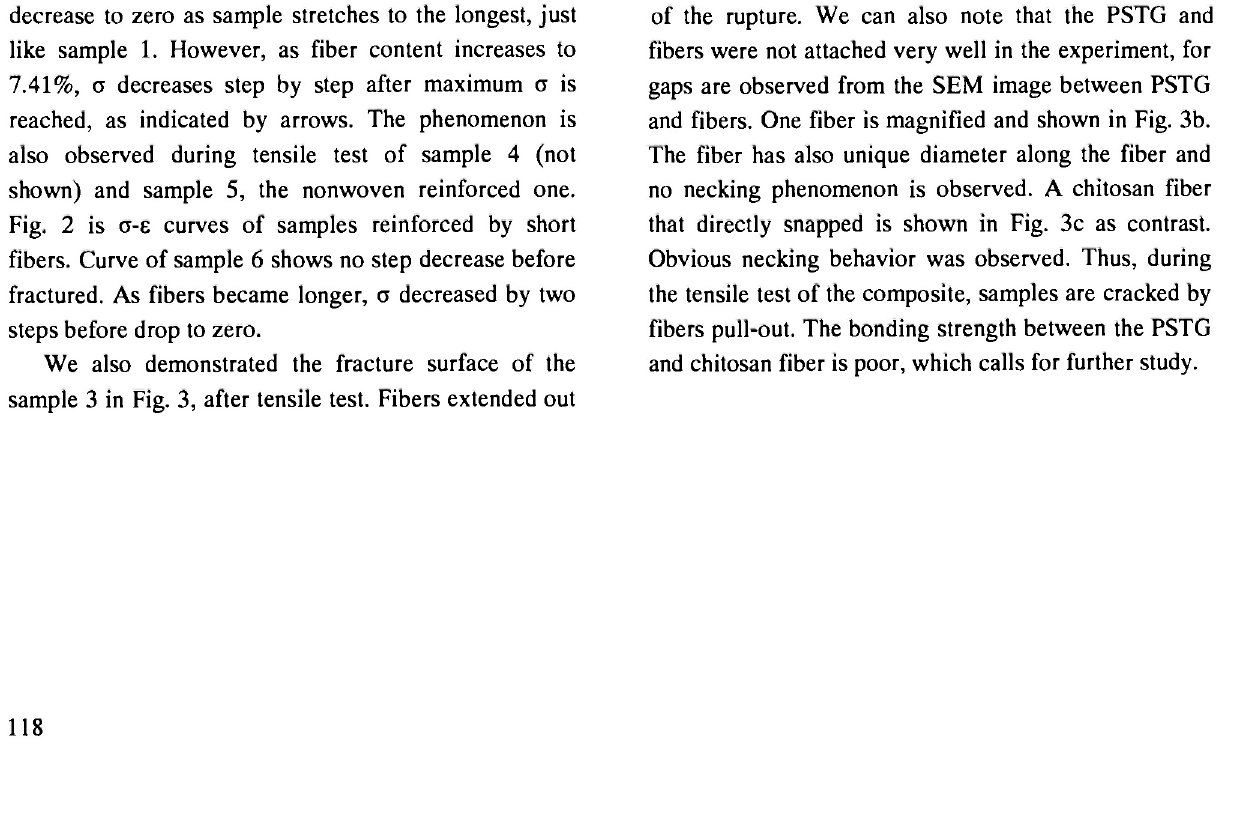
decrease to zero as sample stretches to the longest, just like sample 1. However, as fiber content increases to